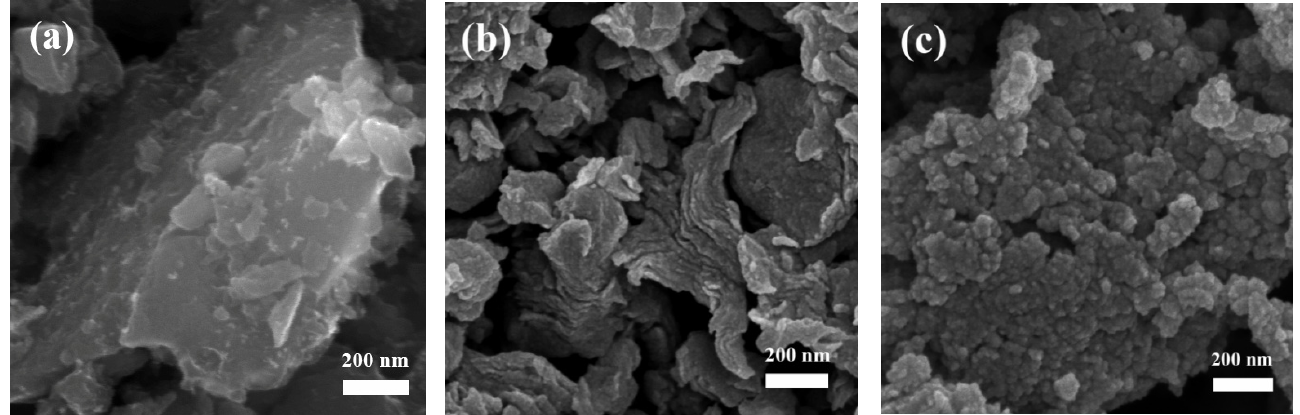
Figure 2. SEM images of ( a ) CBC, ( b ) CBC-Fe(III) and ( c ) CBC-Fe(II).